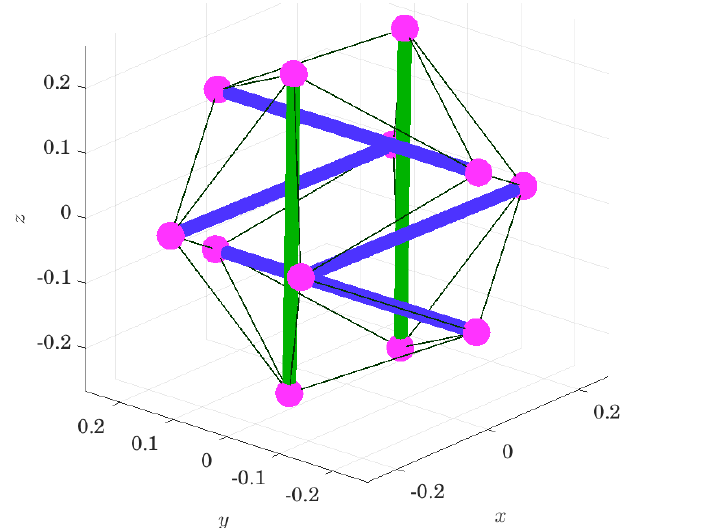
Figure 2. Actuation pattern on the tensegrity drone; static rest length struts are drawn in blue, the actuated struts in green, the nodes in magenta, and the cables in